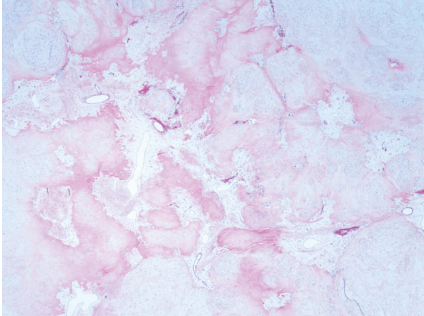
Figure 7: Microscopic image of chondrosarcoma at 10x magni fi cation.